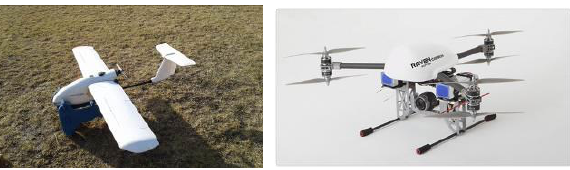
Figure 3. The Skywalker fixed-wing UAV and the AKS Raven X8 multi-rotor